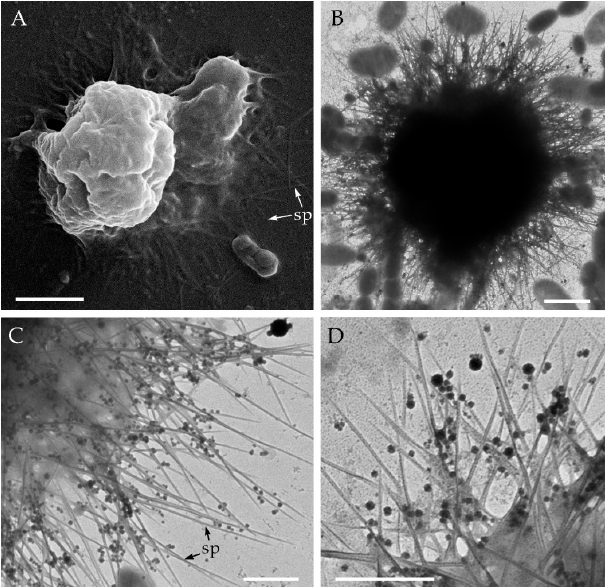
Figure 5. Spicule-bearing stage of Triangulopteris lacunata gen. et sp. nov., HF-25 strain from Kolyma Lowland. ( A )—general view of the dried cell (SEM); ( B )—general view of the dried cell (TEM); ( C , D )—spicules on the peripheral part of cells (TEM). Abbreviations: sp—spicules. Scale bars: ( A , B )—5 μ m; ( C , D )—1 μ m.